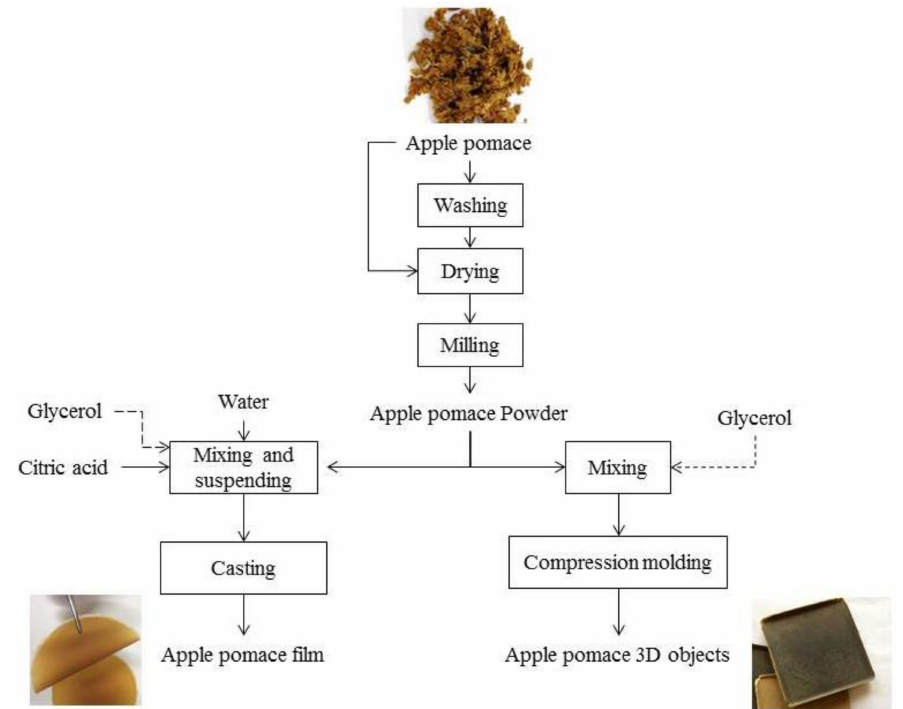
Figure 1. Flowchart of the methods used for production of bio-based films and 3D objects from apple